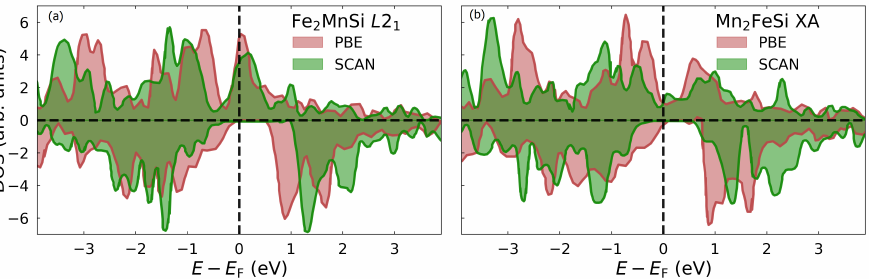
Figure 23. The total DOSs for ( a ) L 2 1 -Fe 2 MnSi and ( b ) XA-Mn 2 FeSi in their ground state structures